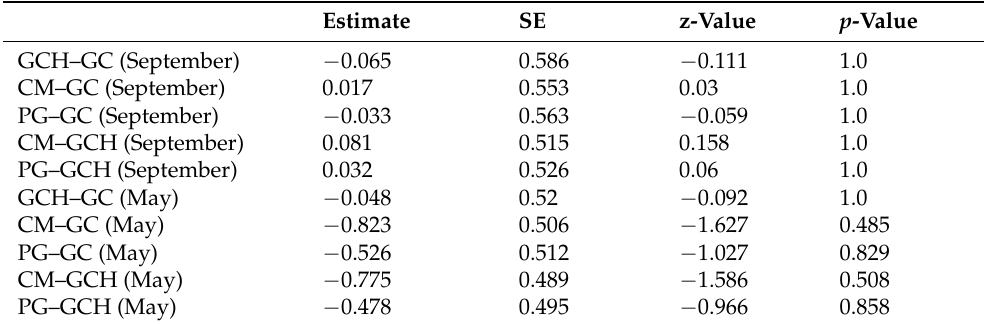
Table A16. Differences in activity densities of red list carabid beetles, comparing grass–clover (GC) and grass–clover herbs (GCH) with each other, and in comparison to conventional maize (CM) and permanent grasslands (PG) in May/June and September.